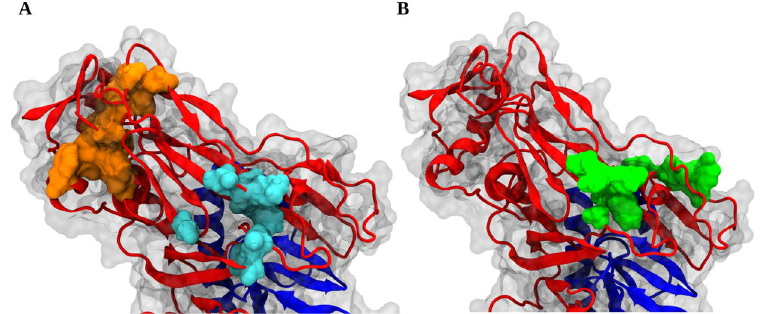
Figure 5. Epitope mapping on E1E2 model. E1 and E2 are represented in transparent surface and blue and red cartoon, respectively. (A) A non-neutralizing mAb (e8) and a broad neutralizing mAb (e137) epitopes are highlighted in cyan and orange, respectively. ( B ) H60 epitope is depicted in